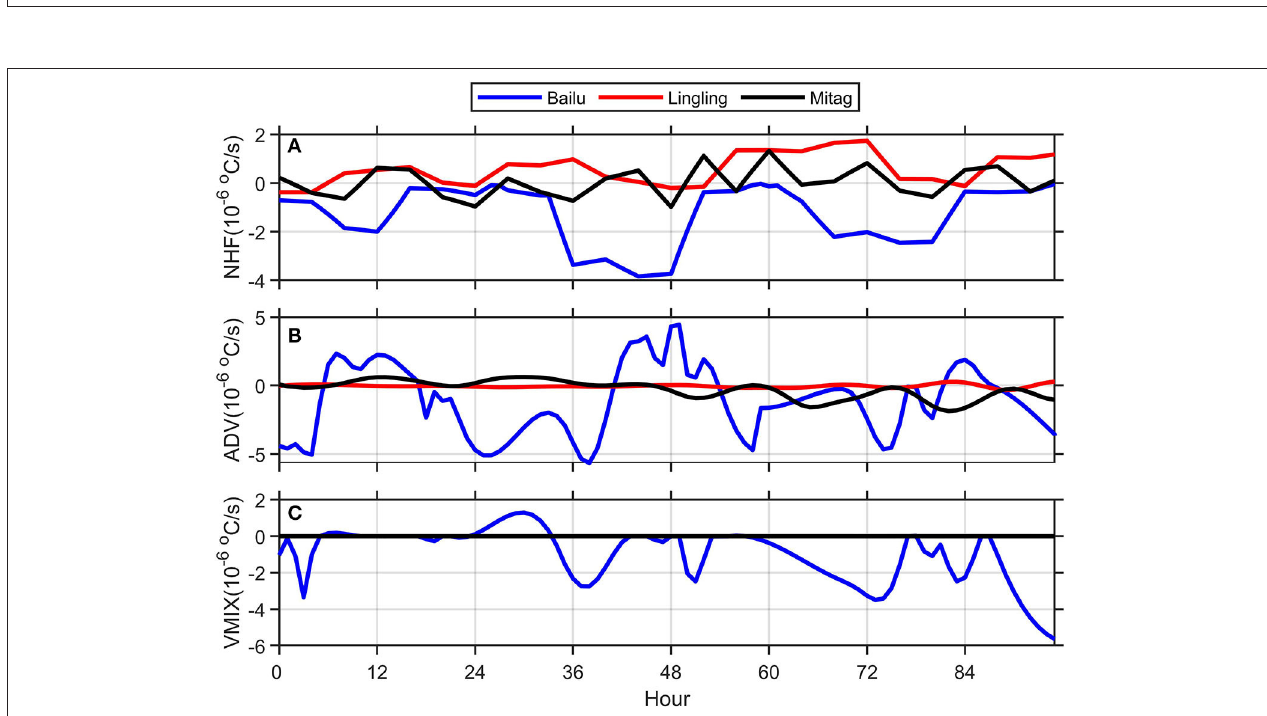
FIGURE 6 | SST tendencies are induced by (A) net heat fluxes, (B) advection, and (C) vertical mixing after TCs. The blue, red, and black lines are during TCs Bailu, Lingling, and Mitag. Data are from numerical experiment 2. TCs, tropical cyclones; SST, sea surface temperature.